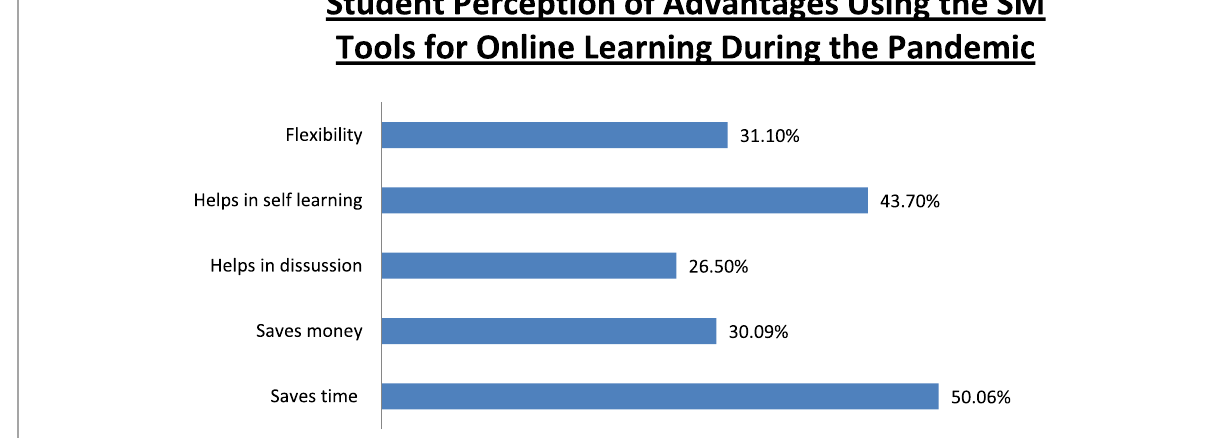
Fig. 3 Student perception of advantages using the SM tools for online learning during the